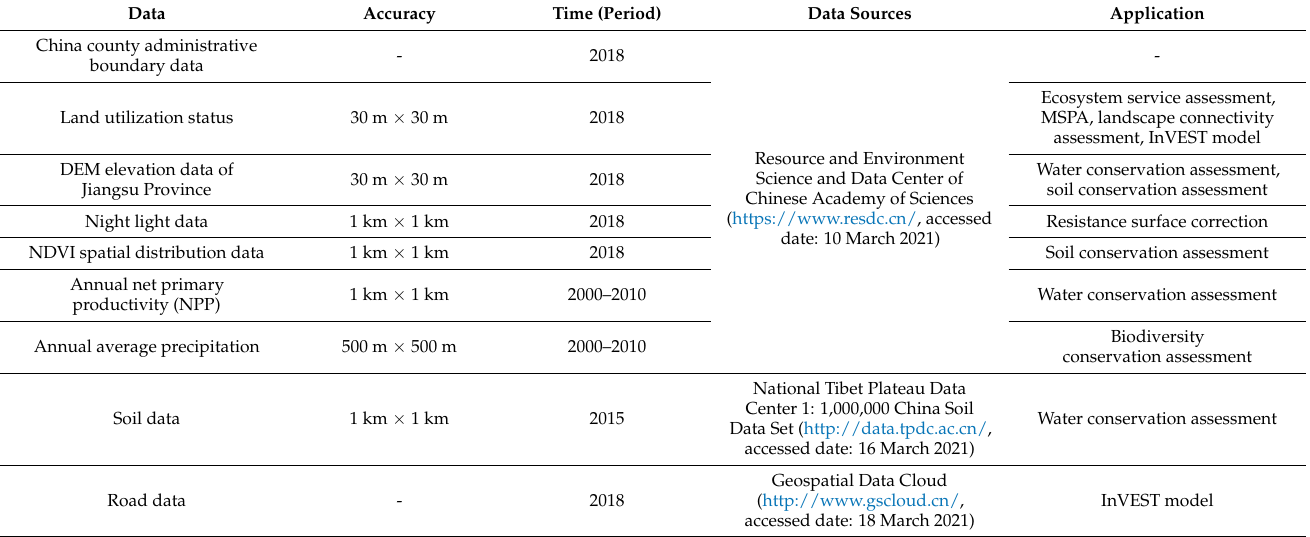
Table 1. Images and text data